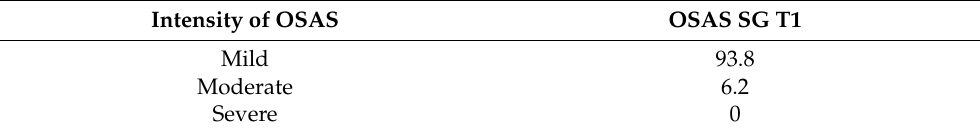
Table 5. Intensity of OSAS of the SG at T1.